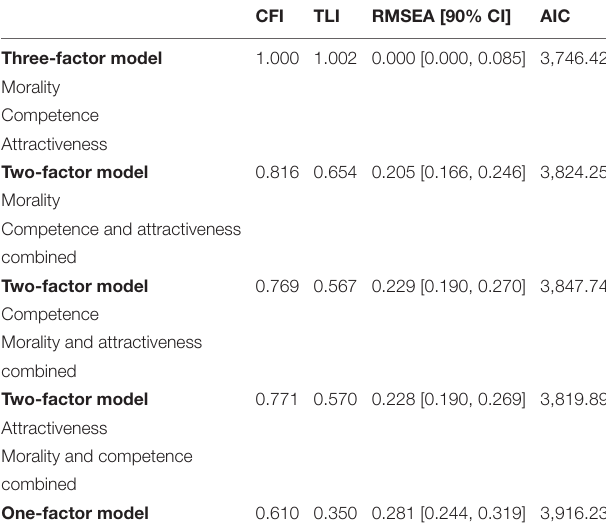
TABLE 1 | Confirmatory factor analyses comparing models with three, two, and one latent factors. CFI TLI RMSEA [90% CI] AIC